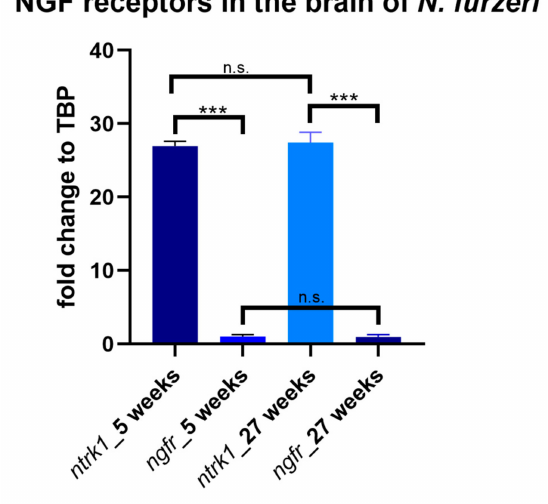
Figure 4. Age-dependent expression of NTRK1 / NTRKA and p75 / NGFR in the brain of N. furzeri . Either NTRK1 / NTRKA and p75 / NGFR display unchanged expression levels between young and old stages ( NTRK1 / NTRKA p value = 0.27; ngfr p value = 0.54). However, comparing the expression of the two receptors, ntrk1 is significantly more expressed than p75 / NGFR , in both 5 ( p value ≤ 0.0001) and 27 ( p value ≤ 0.0001) weeks post hatching animals. *** p value ≤